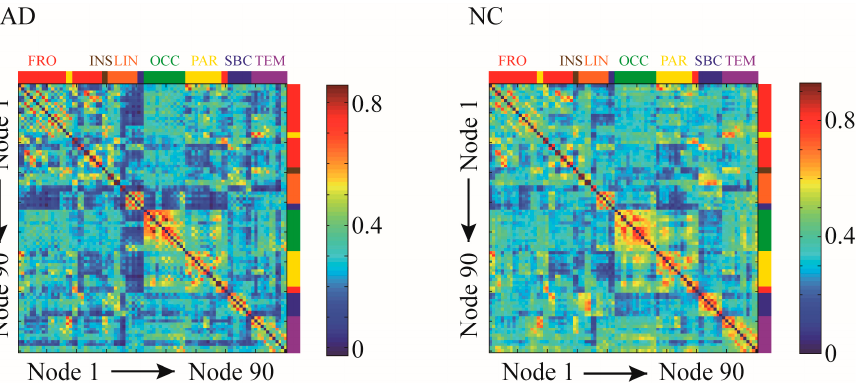
Figure 2. Correlation matrices of the functional brain networks in two groups. The correlation matrices of the brain function networks of group Alzheimer disease (AD) and normal controls (NC) were calculated based on 90 regions in the AAL90 template. The brain regions of the AAL90 template are assigned, where red represents the frontal lobe, yellow represents the parietal lobe, green represents the occipital lobe, purple represents the temporal lobe, brown represents the insula, orange represents the limbic system and blue represents the subcortex.